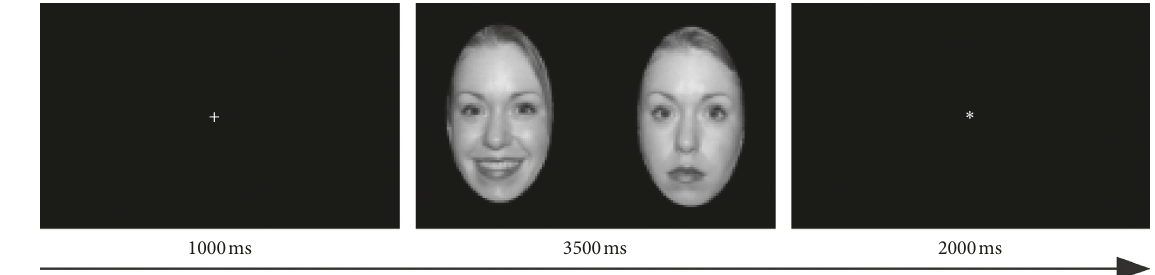
Figure 3: Data acquisition process. Table 1: Analysis of differences between groups in 42 classification features (FDR corrected t -test). Minimum Lower